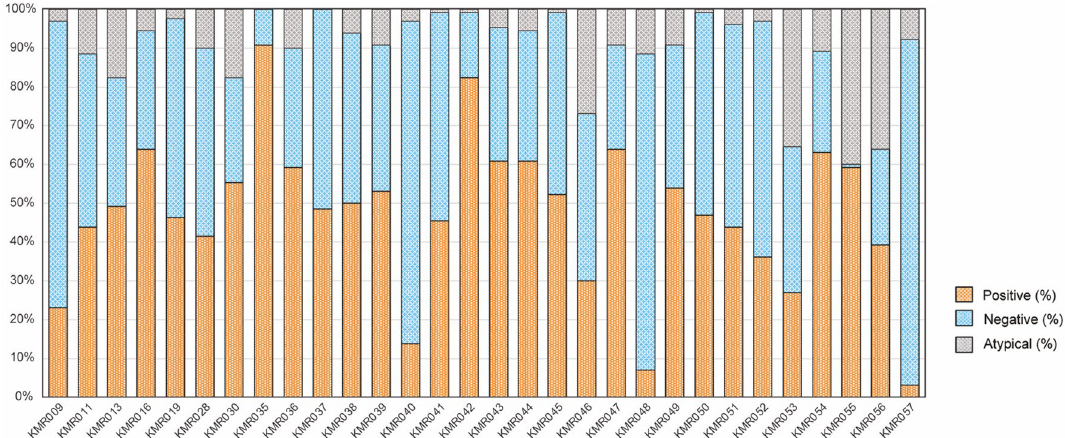
Figure 1. Positivities/negativities of markers in KMRtype Core kit. Proportions of individuals positive or negative for each marker by typing with the KMRtype Core kit. “Atypical” indicates PCR reaction with either a lower or higher Cq than the preset